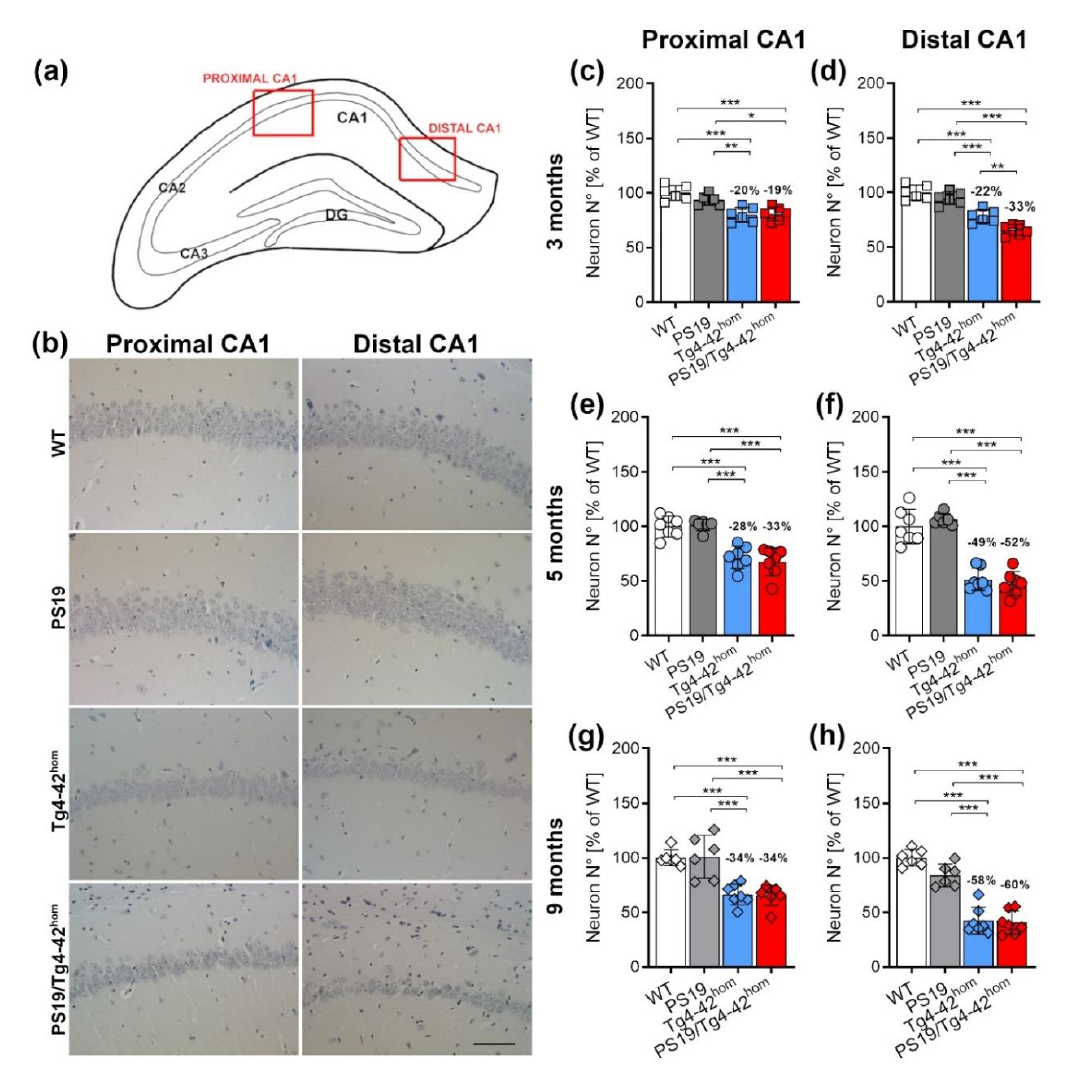
Figure 4. Increased distal CA1 neuron loss in young PS19/Tg4–42 hom mice. Sagittal paraffin brain sections (n = 3 per animal) from female and male WT, PS19, Tg4–42 hom and PS19/Tg4–42 hom mice ( n = 6–7) were stained with hematoxylin. ( a ) Images were taken at 400x magnification from the distal and proximal part of the hippocampal CA1 pyramidal layer. ( b ) Example images of the CA1 pyramidal layer at 5 months of age. Tg4–42 hom and PS19/Tg4–42 hom mice displayed a comparable neuron loss at 5 and 9 months of age in both distal and proximal CA1 ( e–h ). In young PS19/Tg4–42 hom mice, a significant reduction in neuron numbers was observed compared to Tg4–42 hom in the distal ( d ), but not in the proximal CA1 area ( c ). All data are given as mean ± SD. One-way ANOVA followed by Bonferroni’s multiple comparison test: * p < 0.05, ** p < 0.01, *** p < 0.001. Scale bar: 50 µ